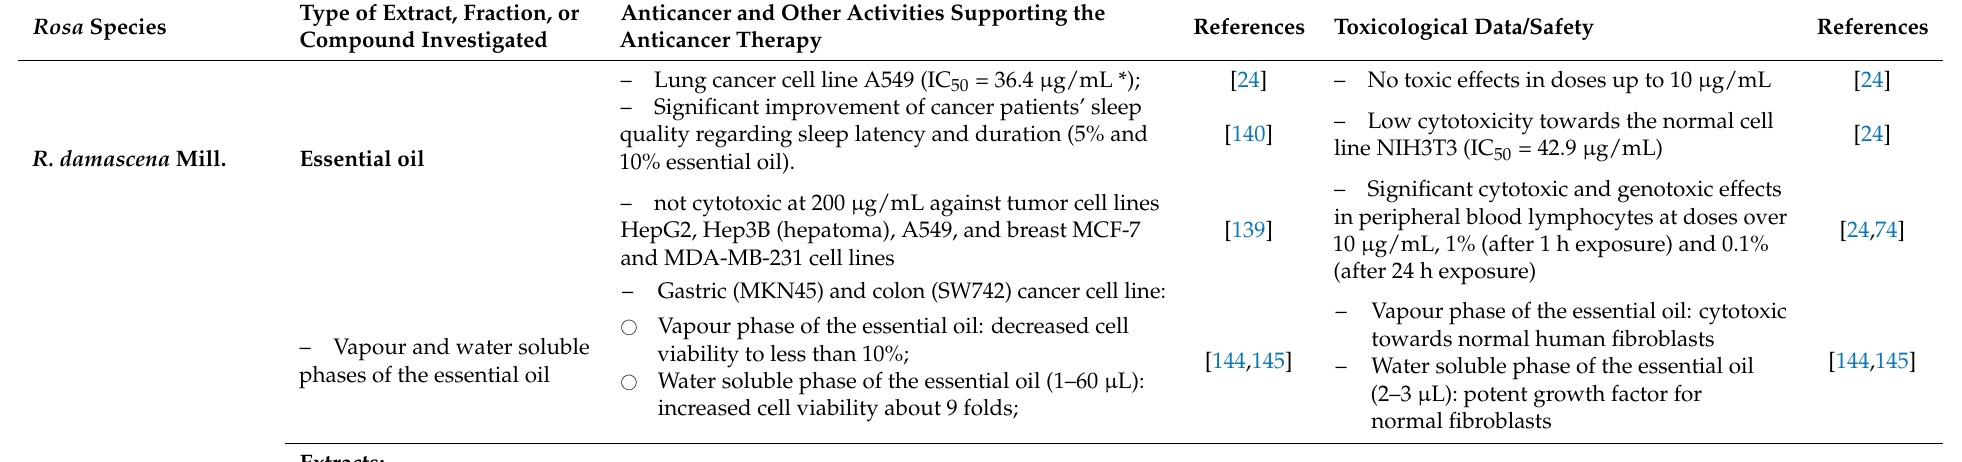
Table 5. Antineoplastic activity and toxicological